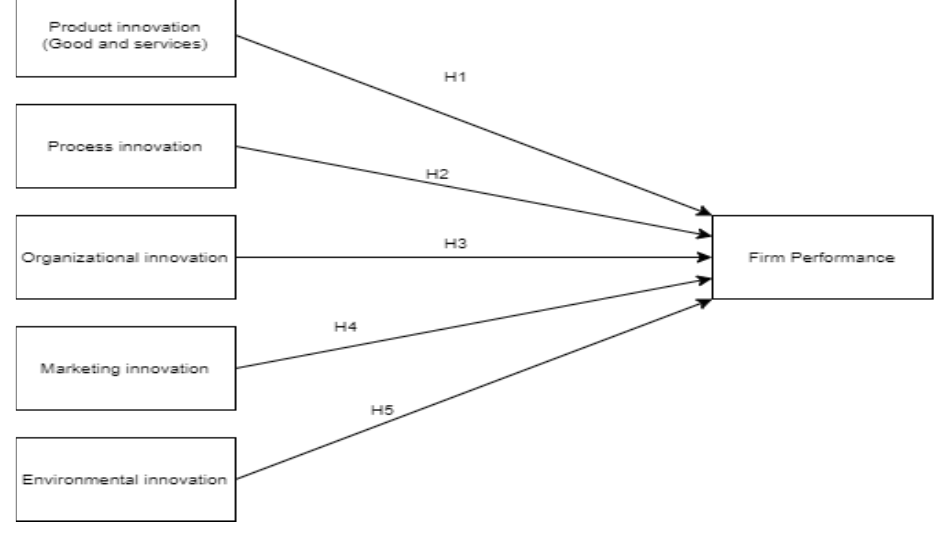
Figure 1: Conceptual Research Model; Source : Authors